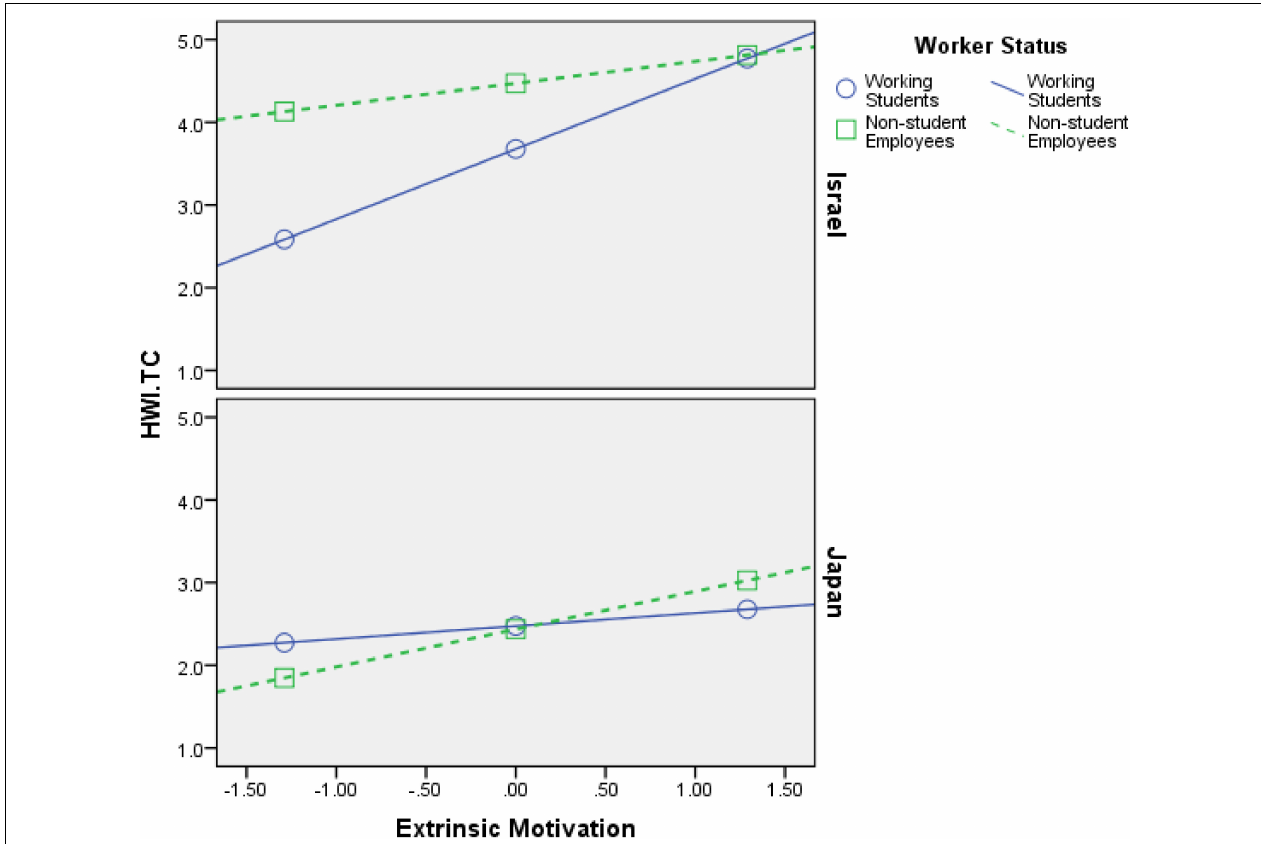
FIGURE 3 | Interaction effects of Extrinsic Motivation × Worker’s Status × Country in predicting HWI-TC. HWI-TC, time commitment dimension of heavy work investment.